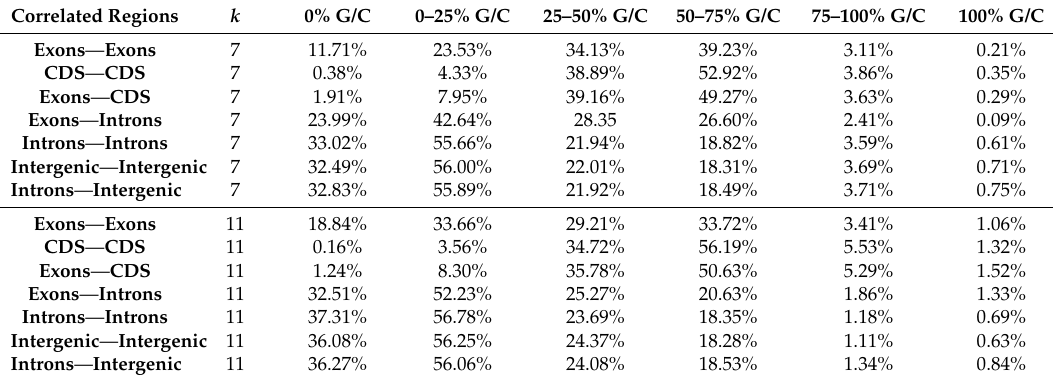
Table 6. Correlation contributions of words with different G/C contents for word lengths k = 7 and k = 11, between different genome regions.